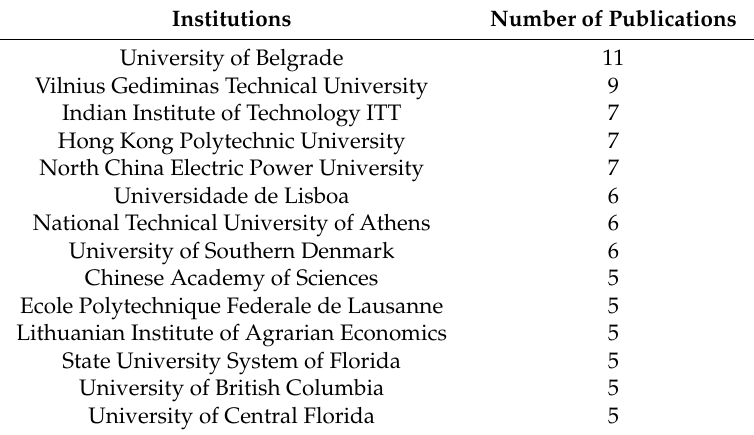
Table 2. The publications by institutions on the topics of “multi-criteria decision making” and “sustainable energy”,